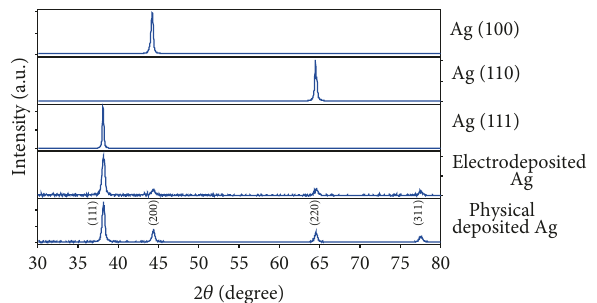
Figure 1: XRD patterns of Ag (100), Ag (110), and Ag (111) crystals as well as the electrodeposited and PVD polycrystalline silver